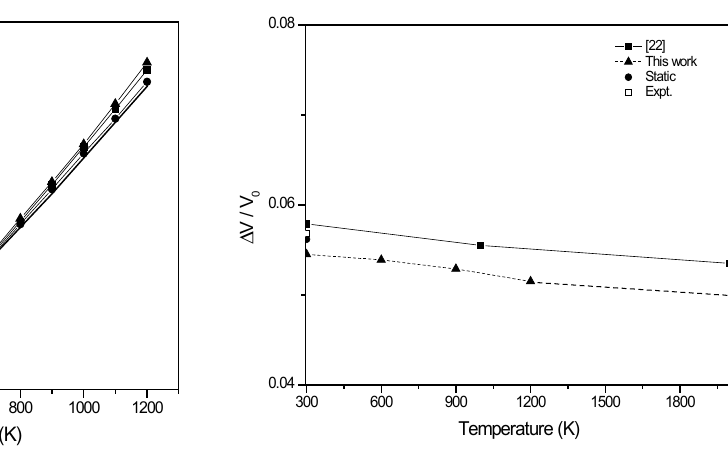
Figure 2. Variation of volume change V